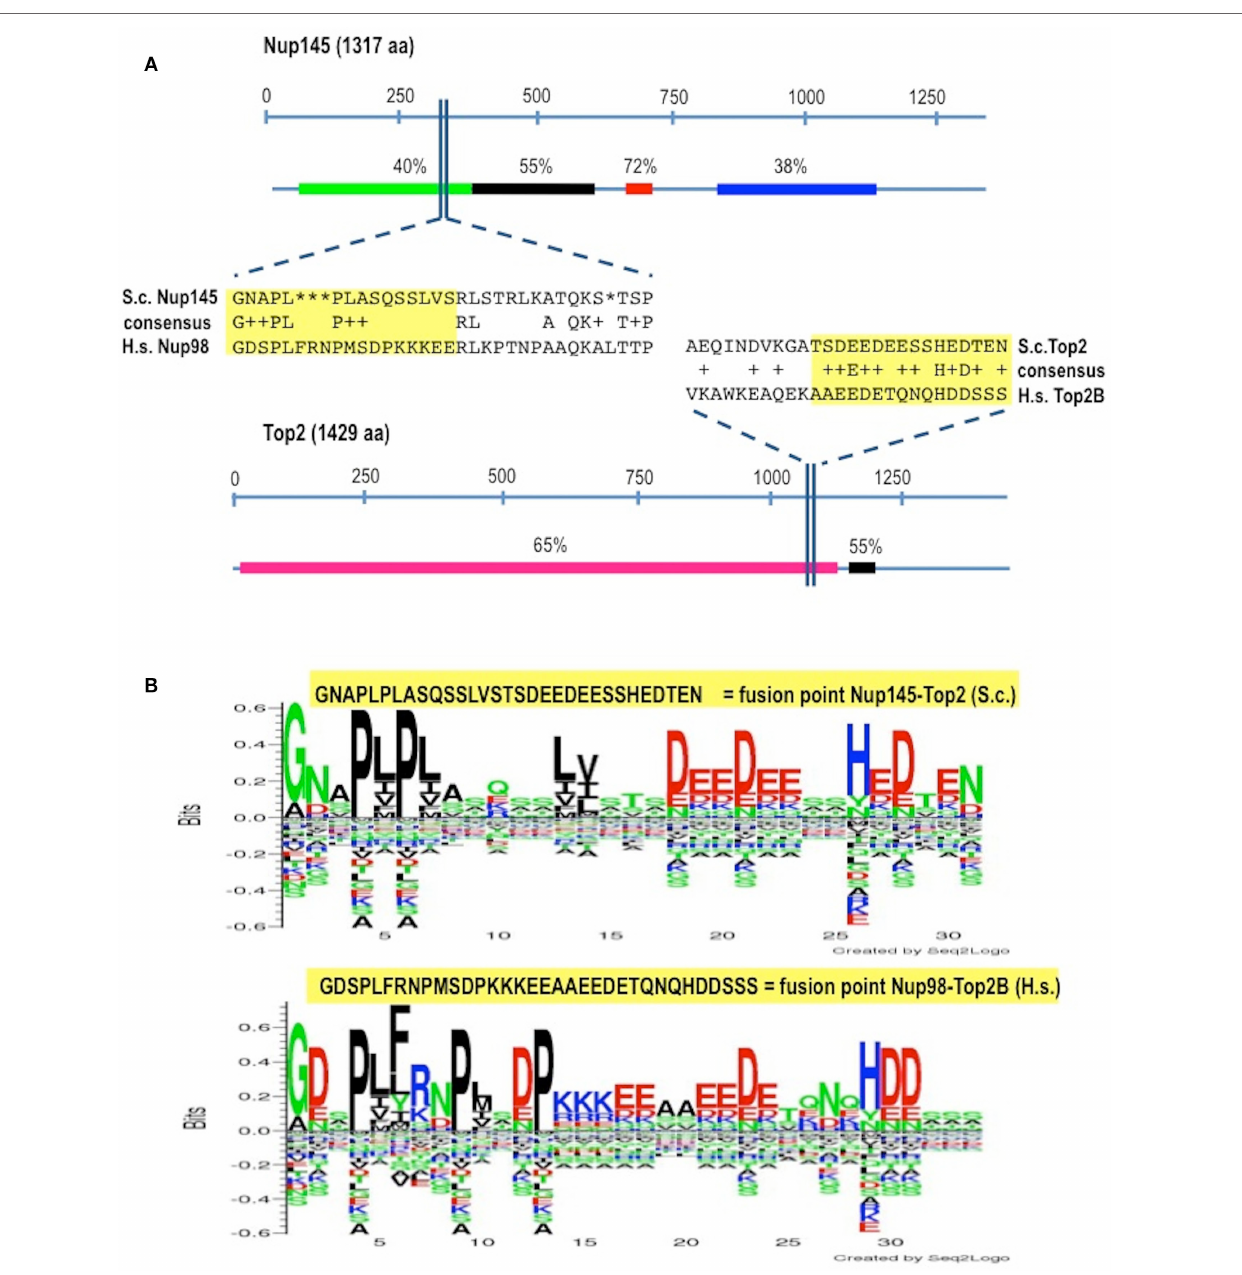
FigUre 1 | Identification of the virtual breakpoints within the yeast proteins Nup145 and Top2 through an alignment with the human orthologs. (a) Breakpoints within the yeast proteins and their homology in percentages with the human orthologs (line below each protein) are shown. In the windows, a partial sequence alignment between yeast (S.c.) and human (H.s.) proteins and the relative consensus are presented. The parts of the proteins that are going to be fused together resulting in chimeras are outlined in yellow. aa, amino acids. (B) The fusion points in yeast (top panel) and in human (bottom panel) are represented by the Seq2Logo server. Large symbols represent frequently observed amino acids, big stack represents conserved positions and small stack represents variable positions. The Y -axis describes the amount of information in bits. The X -axis shows the position in the